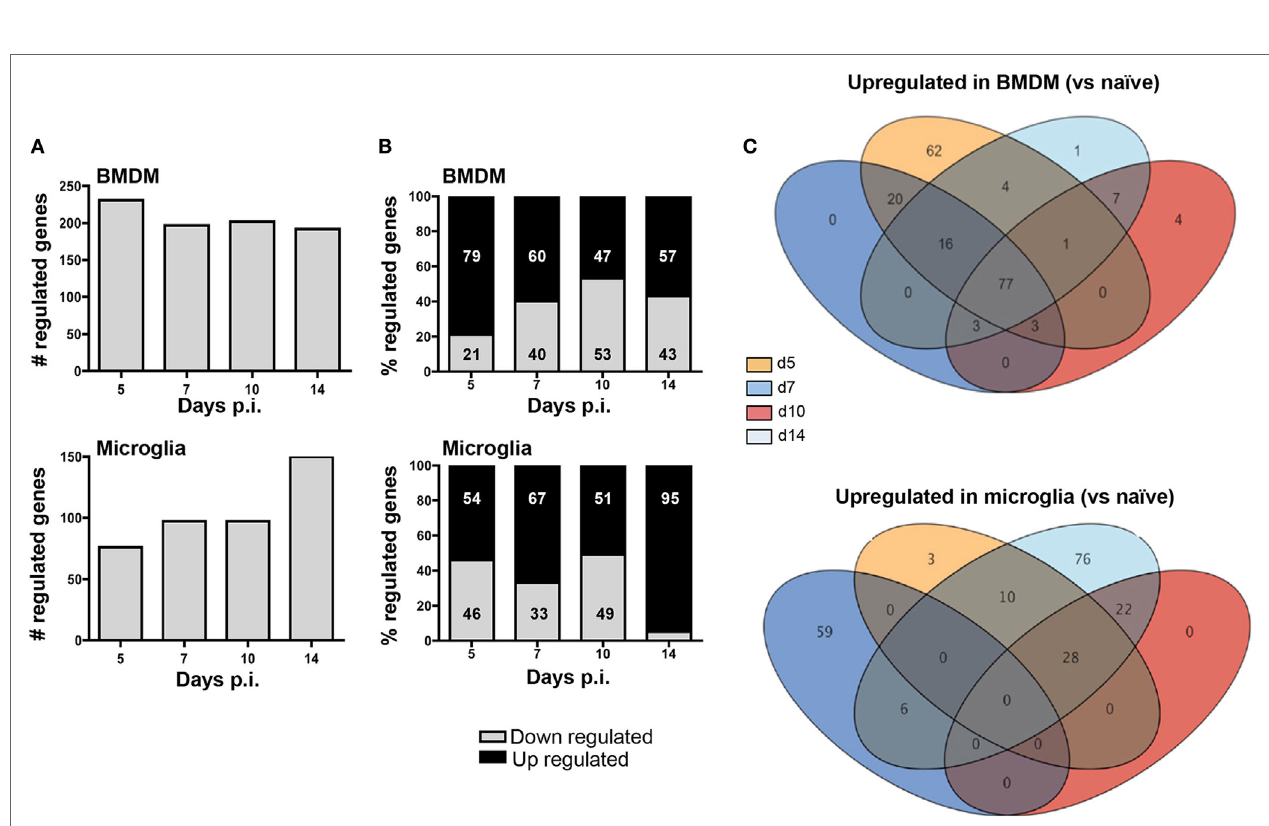
FigUre 4 | Expression profiles of genes commonly expressed by central nervous system (CNS) infiltrating bone marrow-derived macrophage (BMDM) and microglia during JHMV infection. FACS purified BMDM and microglia from spinal cords of JHMV-infected JHMV-infected CX3CR1 GFP/ + CCR2 RFP/ + mice were assessed for differential gene expression by nCounter analysis using the myeloid cell probe panel. (a) Selpig and ApoE genes were chosen as representative genes showing similar expression patterns in BMDM and microglia (B) Ctss, Dusp1, and Tyrobp genes were chosen to highlight distinct regulation in BMDM and microglia throughout infection. Data are obtained from the spinal cords of seven-pooled mice for each time point and represent the fold increase relative to naïve levels at days 5, 7, 10, and 14 p.i. in BMDM and